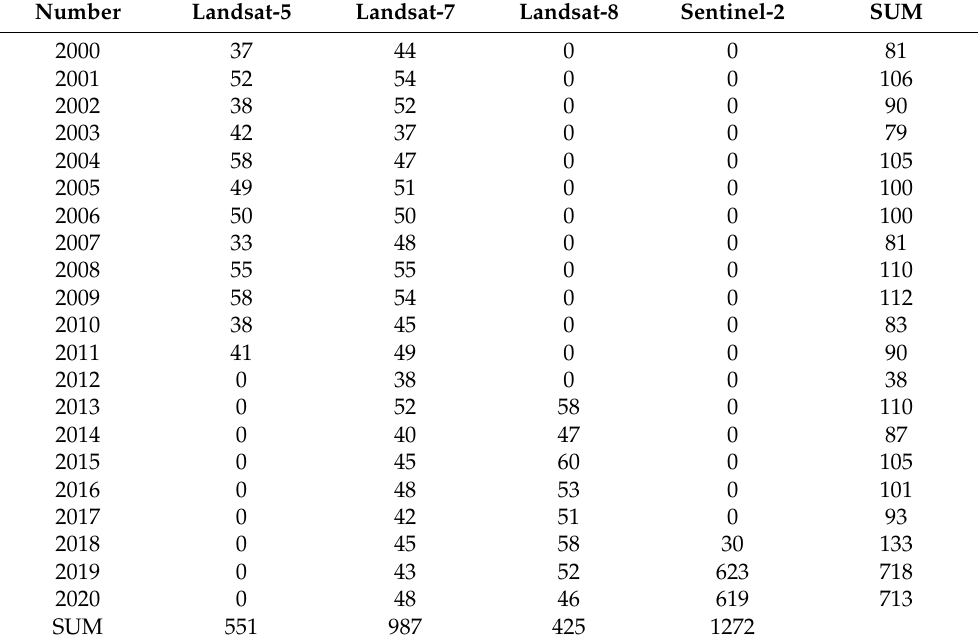
Table 1. The number of images used in our